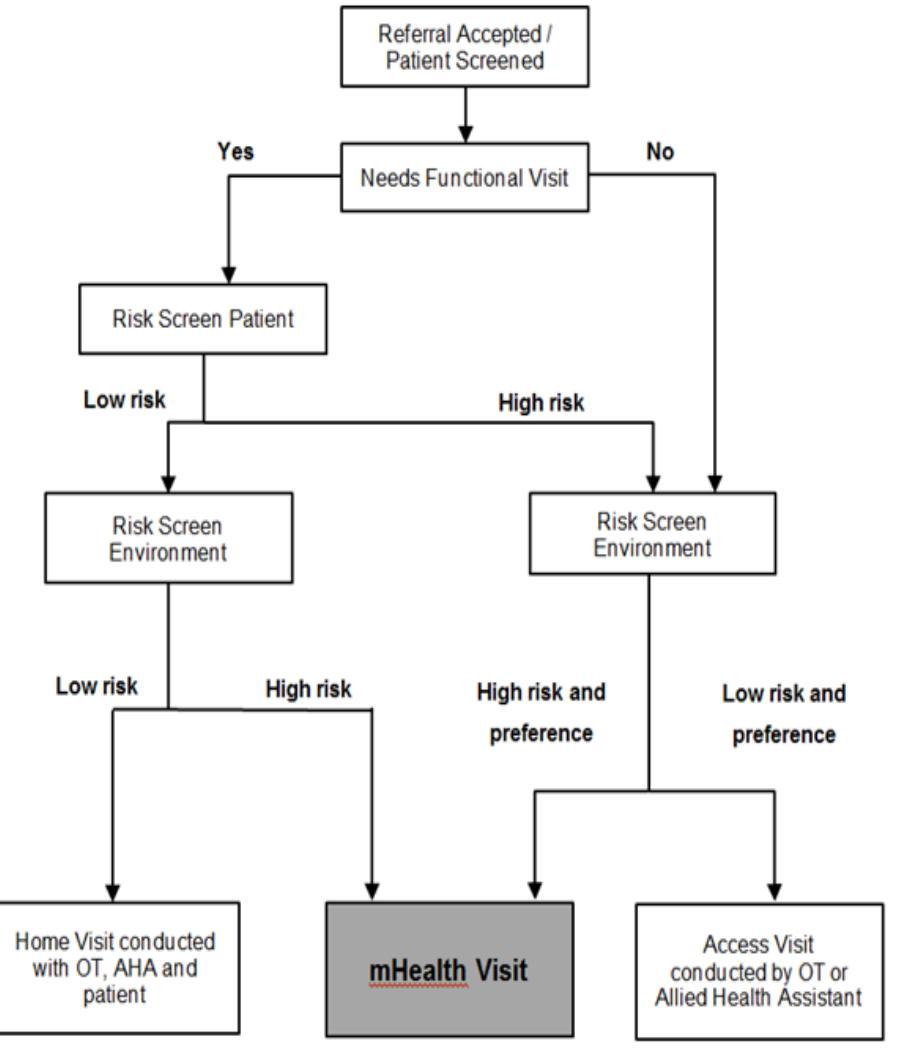
Figure 1. The risk screening tool developed during the pilot implementation